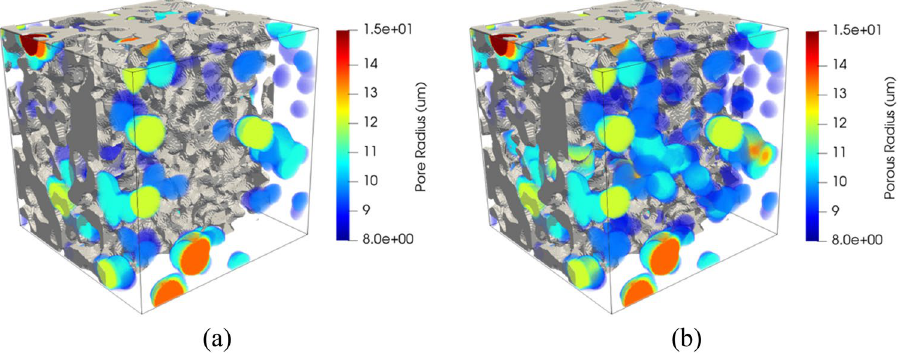
Figure 10. 3D-Rendering showing the local pore sizes computed by simulated MIP ( a ), applying the local thickness method ( b ).